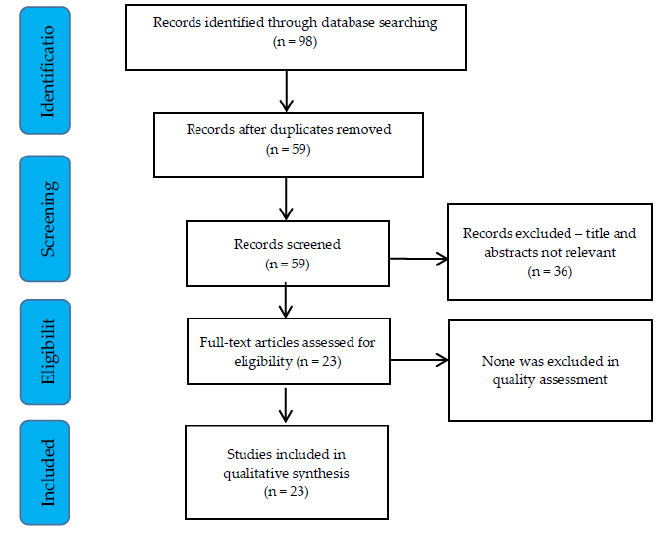
Figure 1. Overview of the search strategy and process of articles’ inclusion.